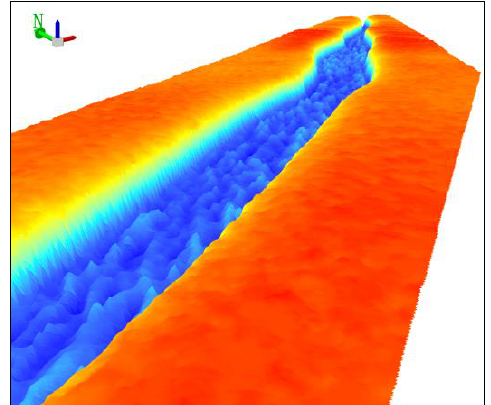
Fig. 2. 3D view of the rift (depth exaggeration 10